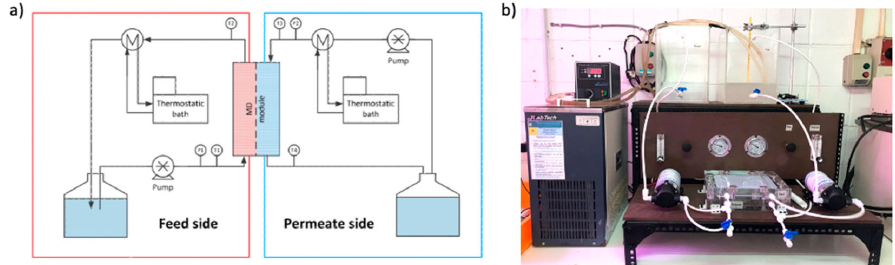
Figure 2. ( a ) Schematic diagram of the DCMD experimental setup and ( b ) the digital picture of DCMD setup for lab